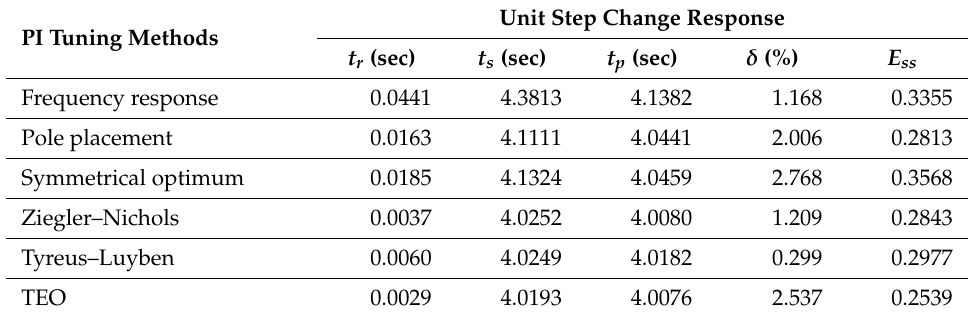
Figure 8. Box-and-Whisker plot of optimization problem (19): ( a ) IAE criterion; ( b ) ISE criterion; ( c ) ITAE criterion; ( d ) ITSE criterion. Table 4. Time-domain performances for controlled DC-link voltage under step changes scenario.